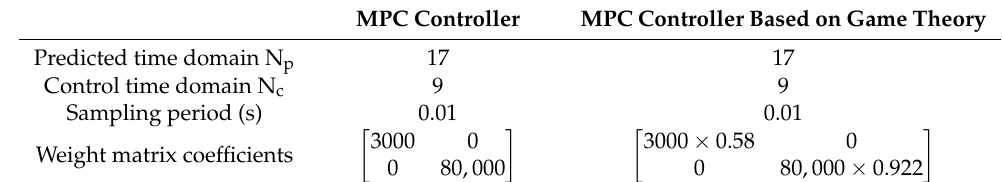
Table 6. Controller parameter settings.